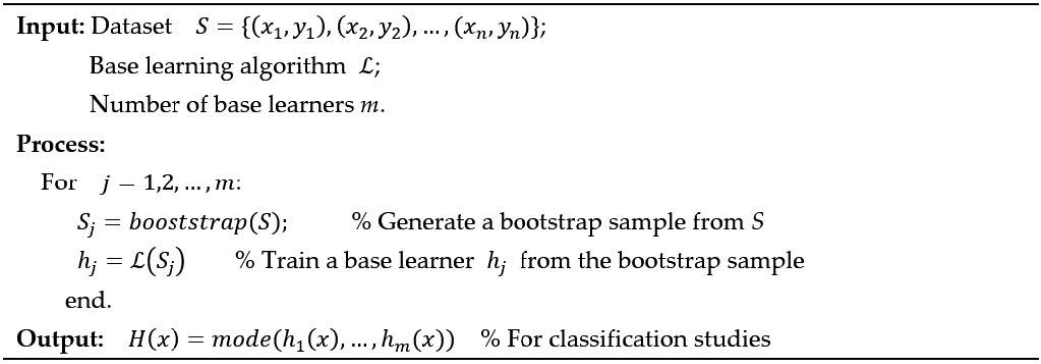
Figure 3. The algorithm of Bagging.